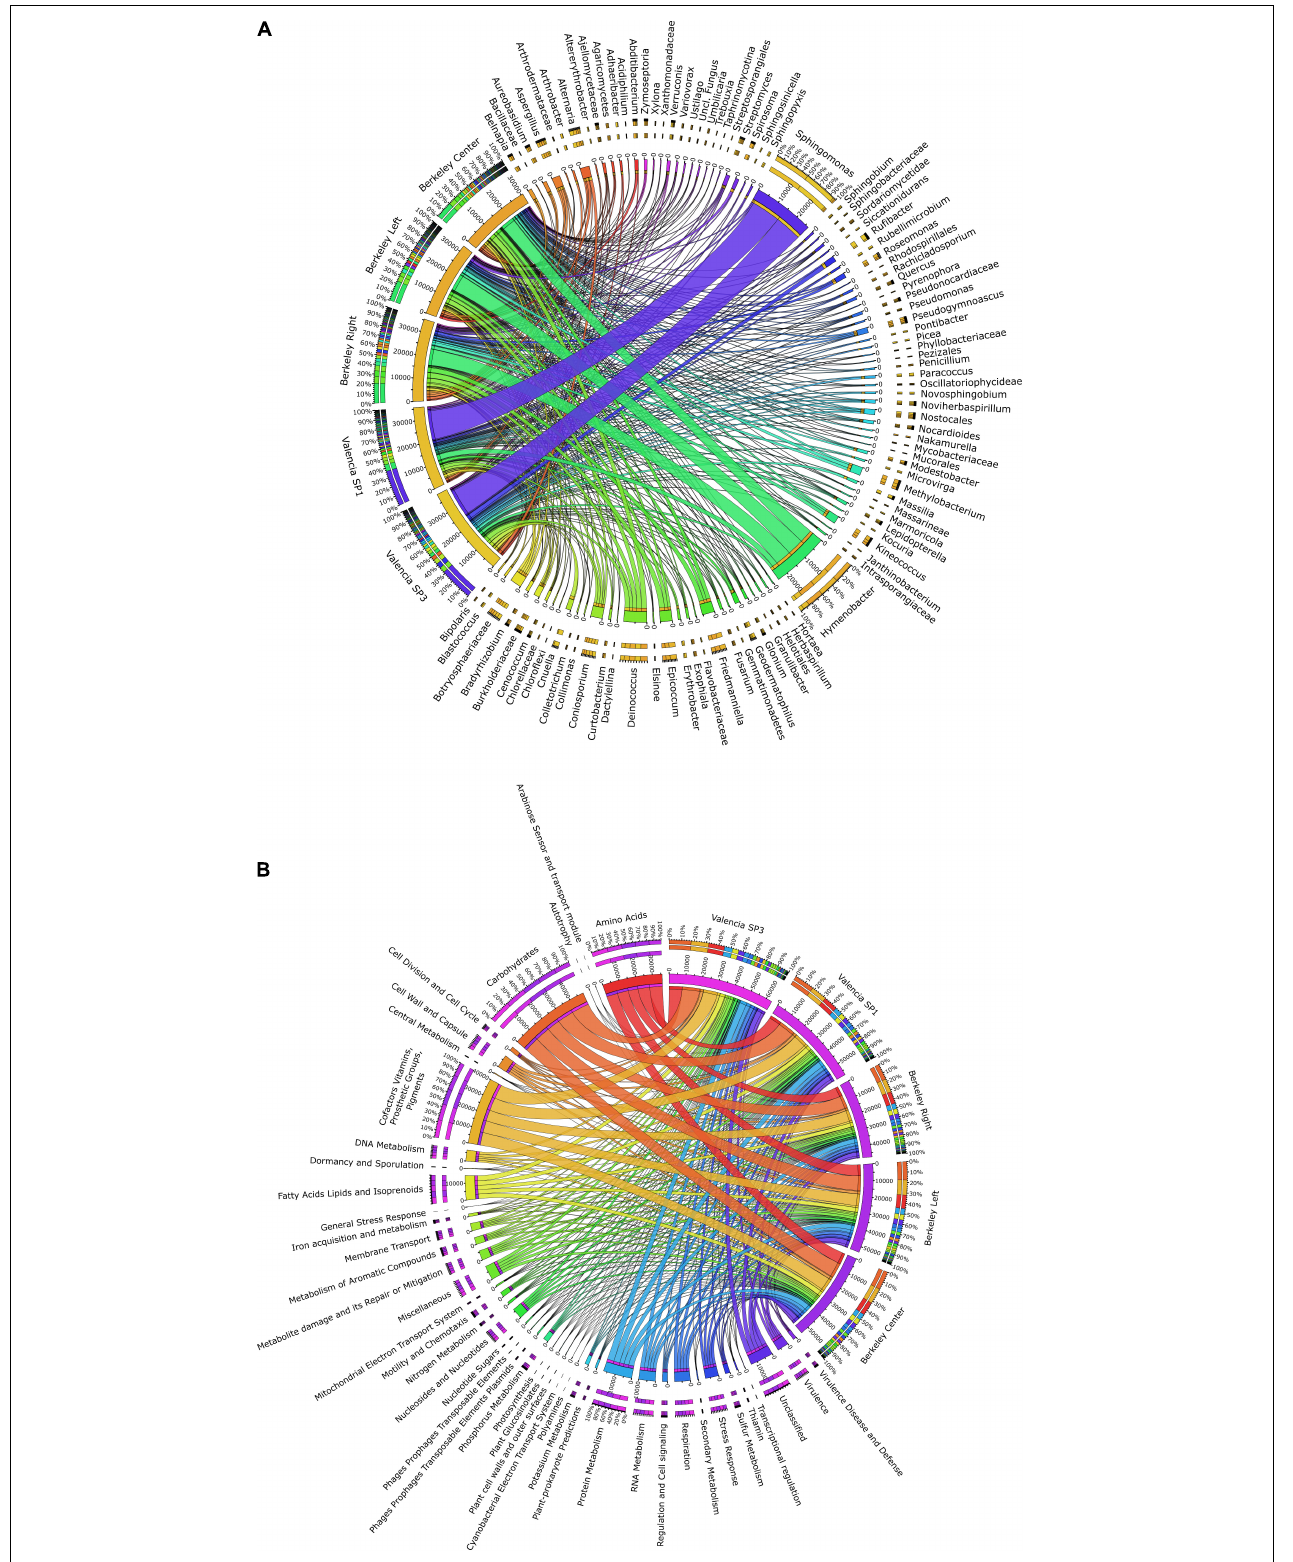
FIGURE 5 | Circos graph connecting (A) microbial taxa at the genus level and (B) SEED functional subsystems to the different metagenomes analyzed in this work (three solar panels from Berkeley, CA, United States, and two solar panels from Valencia, Spain).